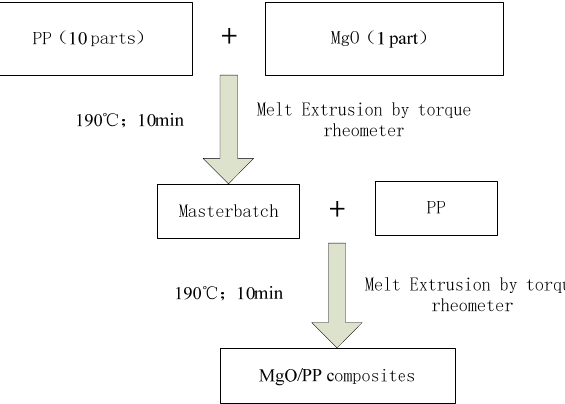
Figure 1. The flow chart of melt blending polymerization.